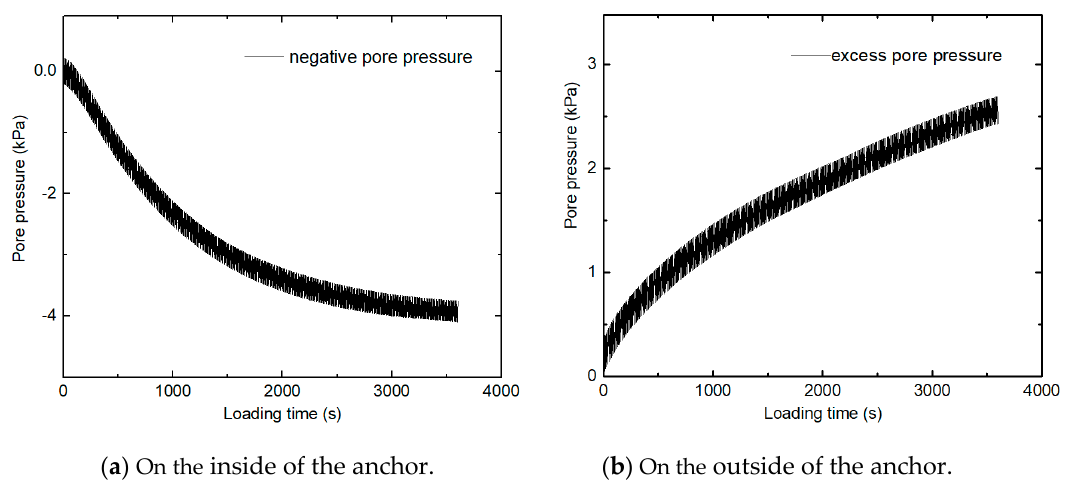
( a ) On the inside of the anchor. ( b ) On the outside of the anchor. Figure 11. Time series of pore water pressure at the location z/h = 0.95 within the seabed.